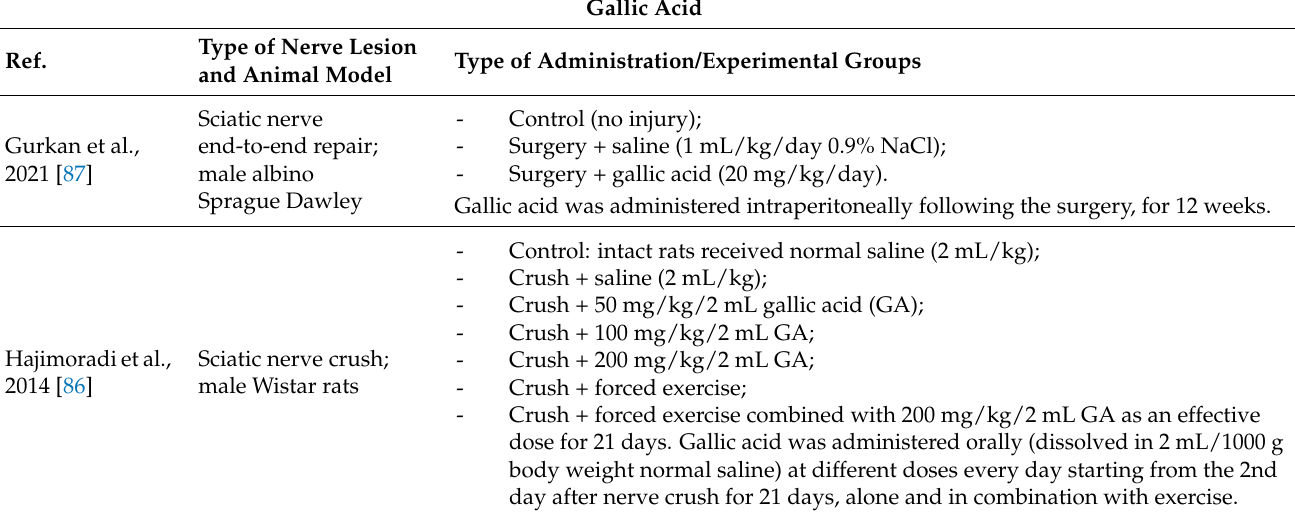
Table 5. Hydroxybenzoic derivatives: Table showing the experimental method (type of nerve injury and animal model), the dose, and method of administration of gallic acid. Included references are listed ascending in accordance to their publication